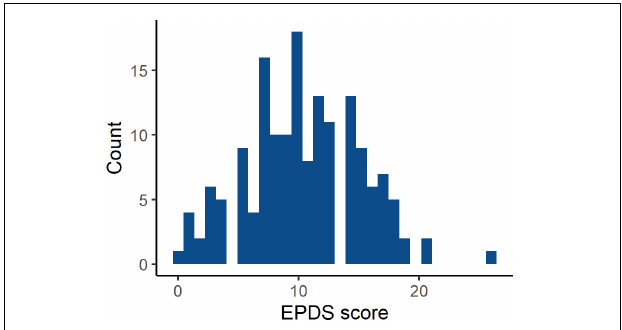
FIGURE 1 | Histogram showing the distribution of Edinburgh Postnatal Depression Scale (EPDS) scores ( N =